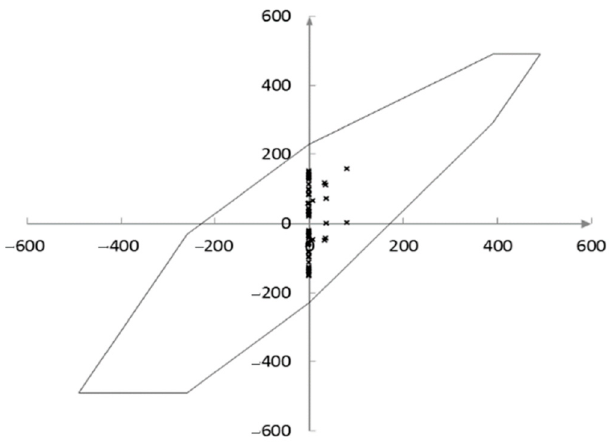
Figure 11. Fatigue strength assessment of booms.